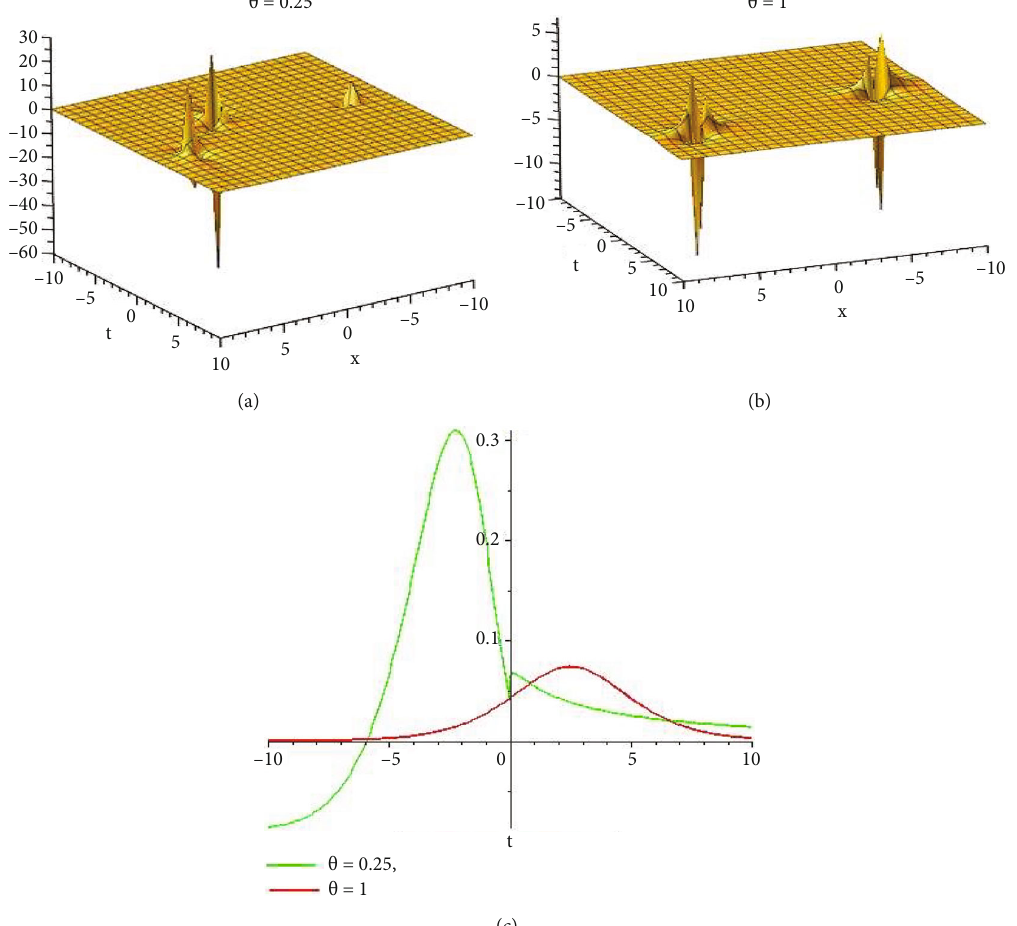
, t Þ . (a, b) 3D plot and (c) 2D combined stripe plot for x = 1 16,17 ð x